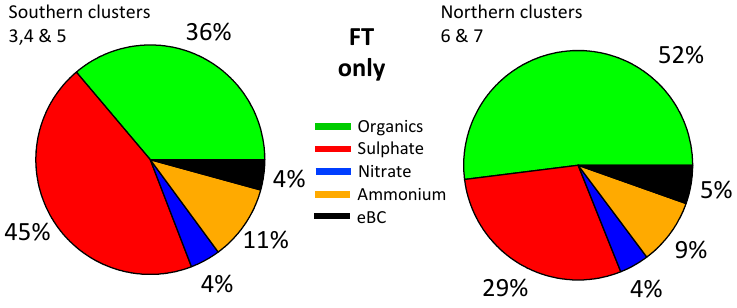
Figure 6. Relative species contributions only during FT conditions separated by air mass origin. Left: southern air masses (clusters no. 3, no. 4 and no. 5 of Fig. 5); right: northern air masses (clusters no. 6 and no. 7 of Fig. 5). Note that contributions of cluster no. 1 were not considered.